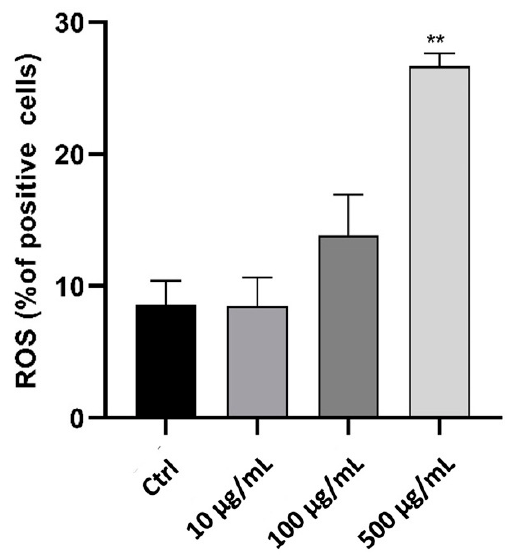
Figure 4. In vitro evaluation of the effect of myrrh methanolic extract on cell apoptosis using Thp-1-like macrophage cells (* p < 0.05).